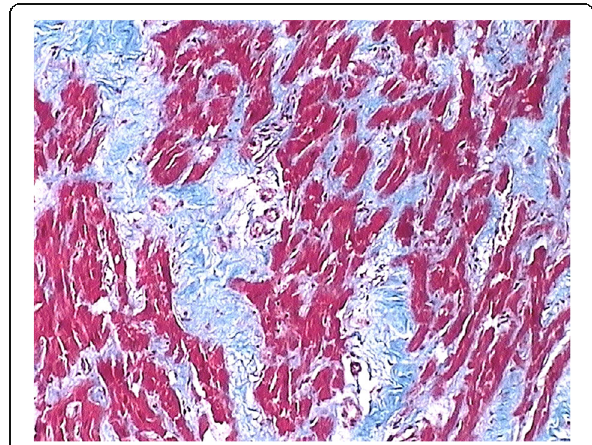
Fig. 2 The histology of the affected myocardium revealed multiple foci of intestitial and pericellurar fibrosis with features of non-specific myocytic hypertrophy. There was no evidence of inflammation or deposition of amyloid. (trichrome stain Χ